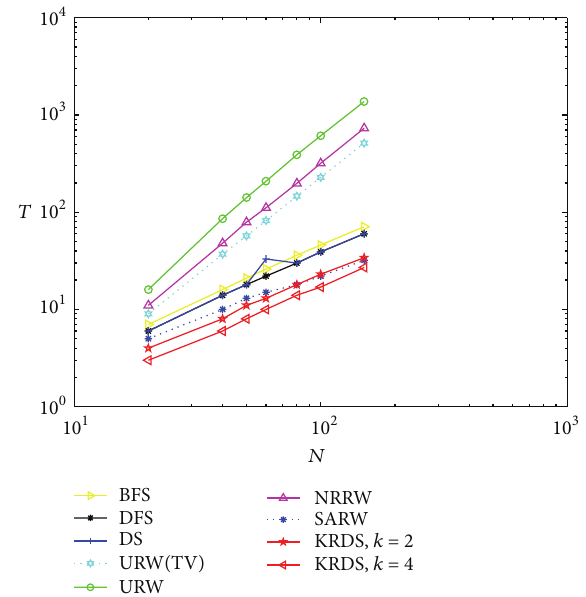
Figure 1: Plot of the average number 𝑇 of the steps versus the network size 𝑁 of the NNCN in the log-log